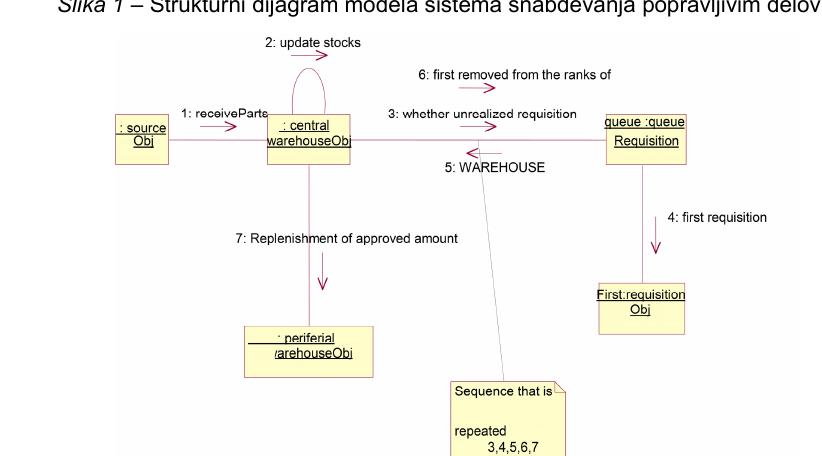
Figure 1 – Class diagram for the model of an inventory system of repairable parts Рис . 1 – Структурная диаграмма модели системы снабжения ремонтных запчастей